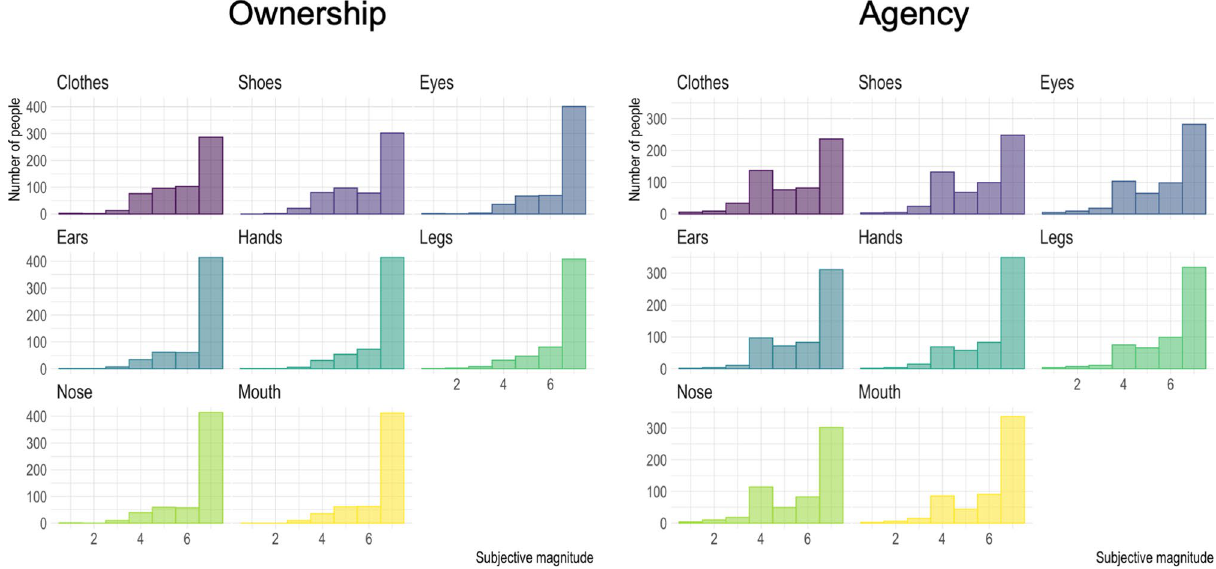
Figure 1. Histograms of the rating score for the ownership and agency sensations in each target. Plots were generated using R software version 4.0.1 (R Core Team (2020). R: A language and environment for